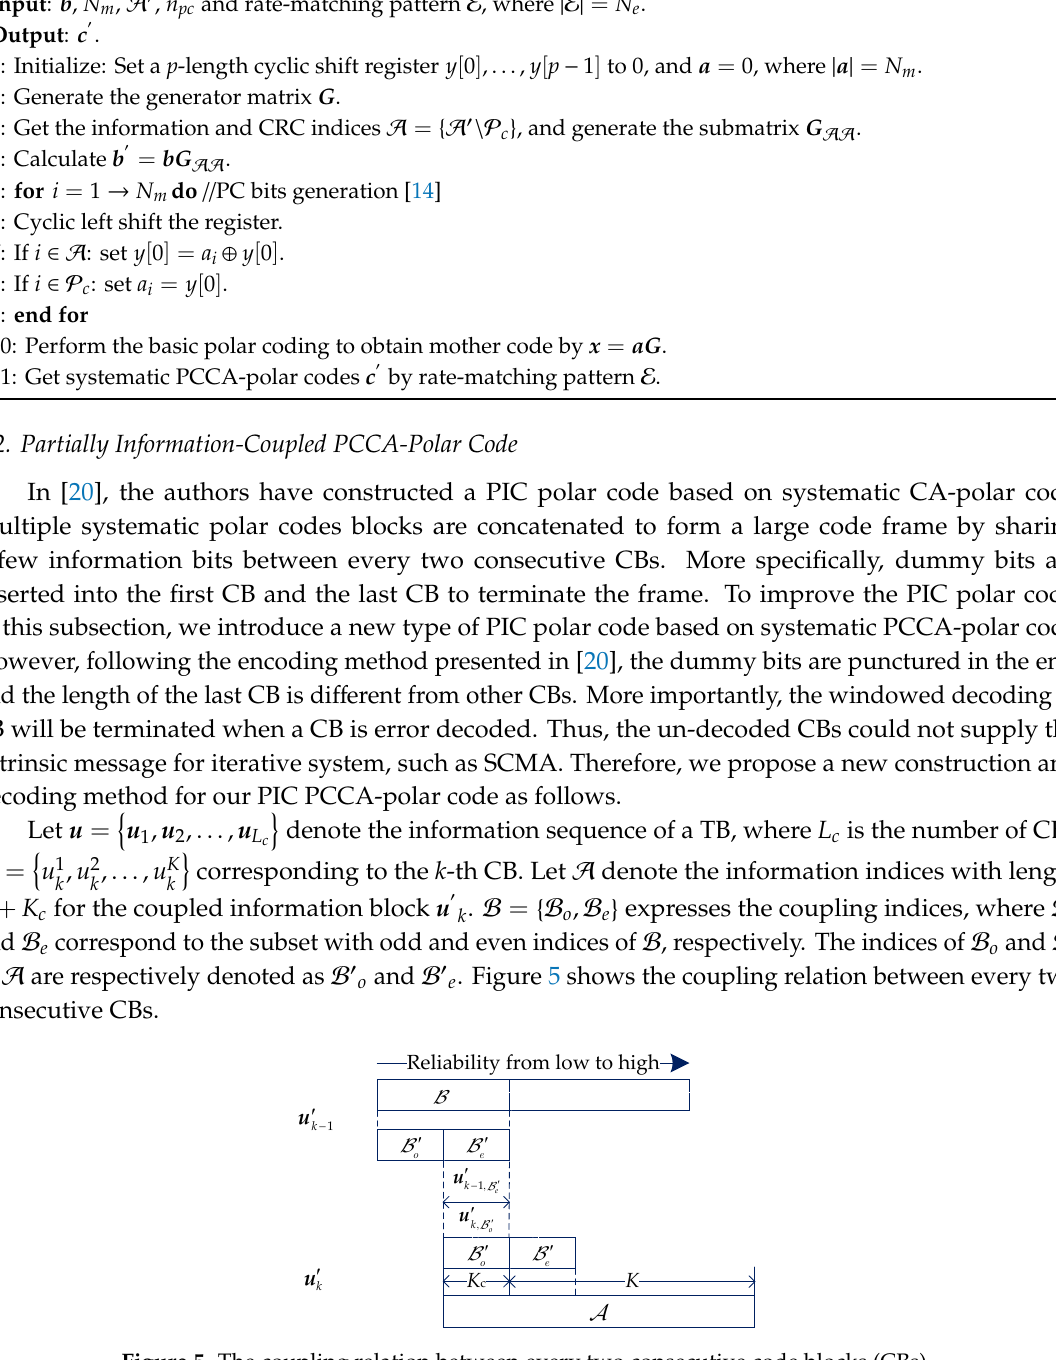
Figure 5. The coupling relation between every two consecutive code blocks (CBs).